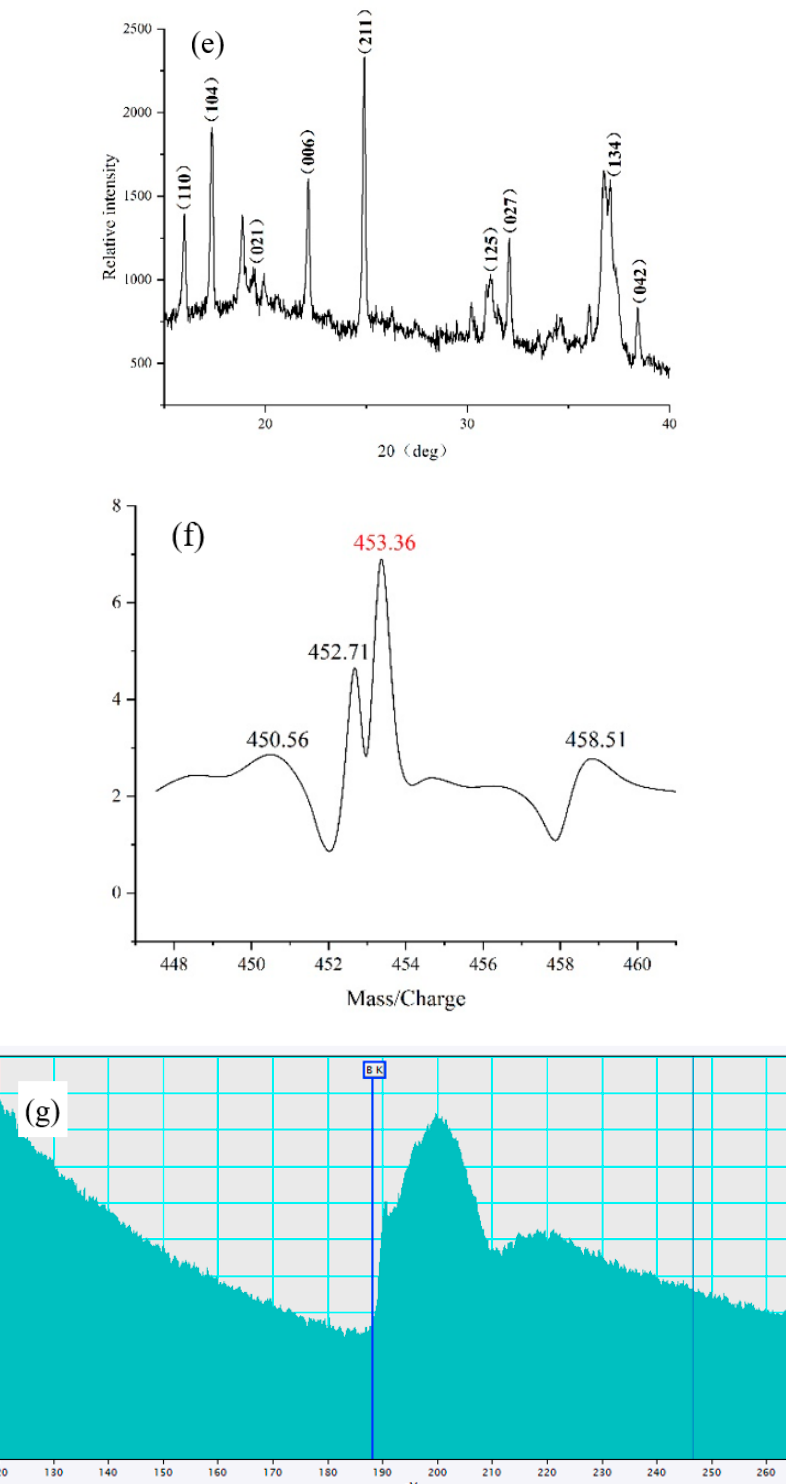
Figure 1. Images of boron particles and boron nanosheets before and after grinding ( a ) SEM image of original boron particles extracted from Cu-5B alloy, ( b , c ) EDS spectrum of boron particles, ( d ) TEM image of boron nanosheets after grinding, ( e ) XRD spectrum of boron nanosheets after grinding, ( f ) MALDI-TOF-MS result for the extracted boron powder, ( g ) the EELS analysis of boron element in boron nanosheets.